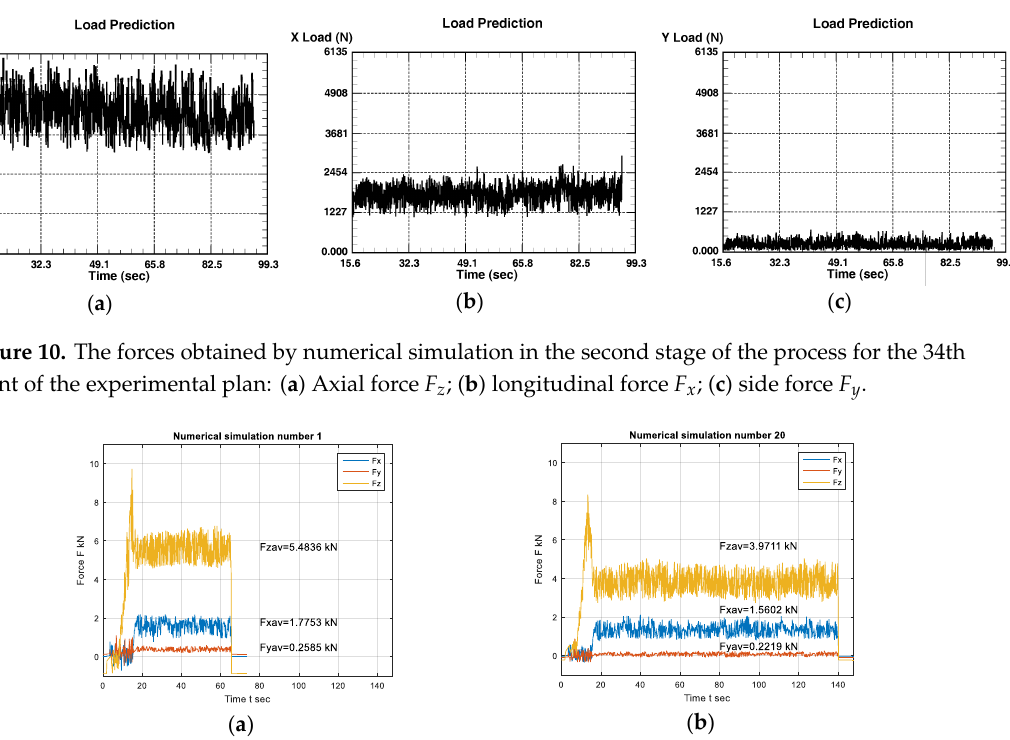
Figure 11. Forces obtained by numerical simulation ( a ) for the 1st point of the experimental plan; ( b ) for the 20th point of the experimental plan.